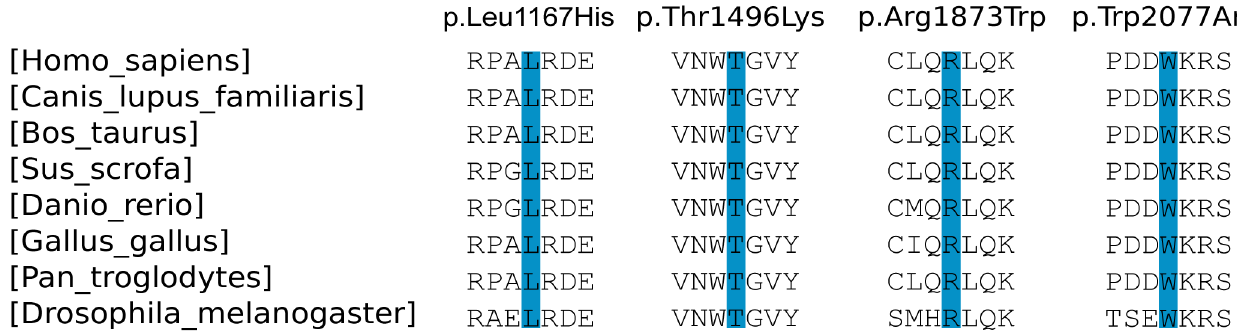
Fig 2. Alignment of MYO7A amino acid sequences from different species. The mutated amino-acids which are highly conservedresidues are highlightedin blue.